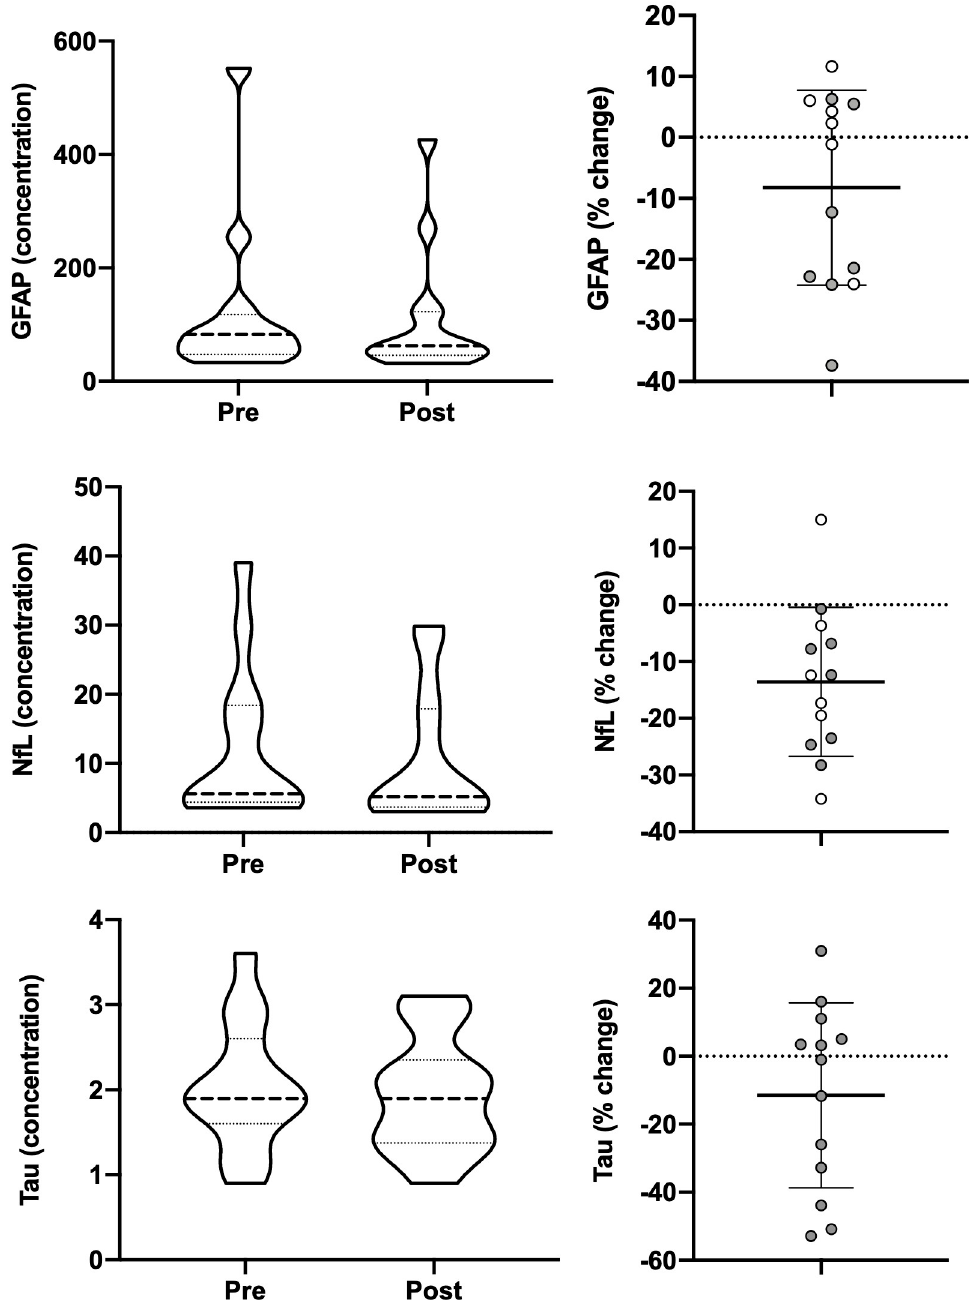
Fig 7. Neuronal injury and neuroinflammation biomarkers. Pre- and post-morning bright light therapy biomarkers for ( A ) Glial Fibrillary Acidic Protein (GFAP), ( C ) Neurofilament Light Chain (NfL), and ( E ) Tau, displayed as truncated violin plots with moderate smoothing (dashed line = median score; dotted lines = 25% and 75% quartiles). Percent change in each Individual for ( B ) GFAP, ( D ) NfL, and ( F ) Tau, plotted with the mean and standard deviation overlaid. Shaded symbols are subjects with co-morbid post-traumatic stress disorder (PTSD), open symbols are subjects without co- morbid PTSD. � = p < 0.05 vs pre; paired two-tail t-test.